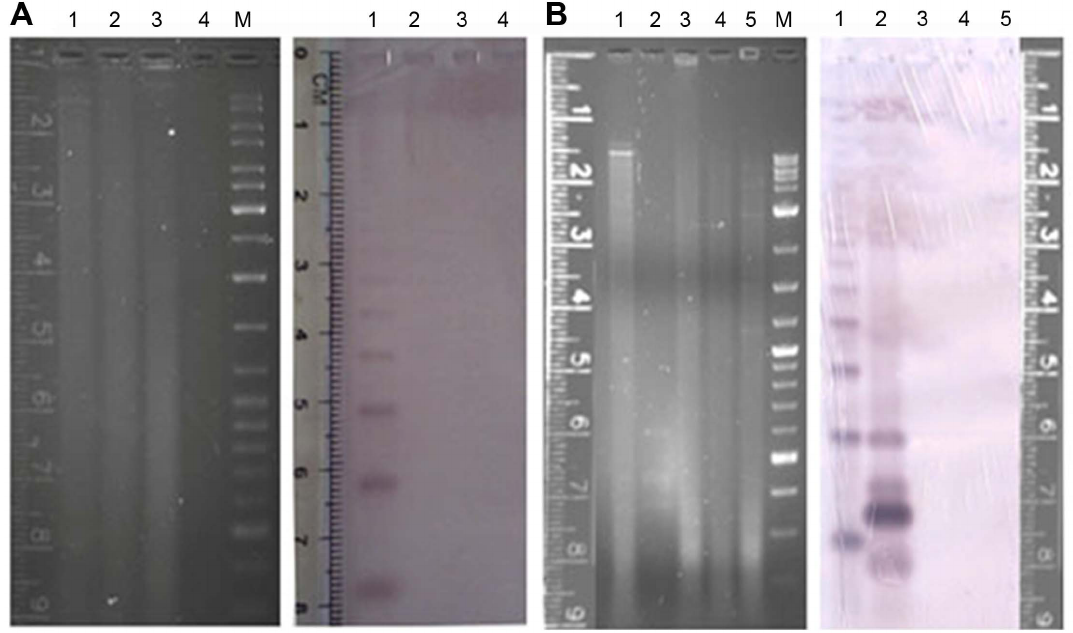
Figure 8. Species distribution of BoR300 repeats. HaeIII-digested genomic DNA of representative species of the Diptera family and the genus Bactrocera was analyzed by Southern hybridization using as probe the biotinylated monomer (298 bp) of the repeat. ( A ) Southern blot analysis of digested genomic DNA from the following dipteran species: B. oleae (lane 1), C. capitata (lane 2), D. melanogaster (lane 3) and An. gambiae (lane 4). B ) Southern blot analysis of digested genomic DNA from the following Bactrocera species: B. oleae (lane 1), B. correcta (lane 3), B. cucurbitae (lane 4), and B. dorsalis (lane 5). In Lane 2 is the cloned monomer of the repeat. M represents the molecular marker (SM0331, Fermentas).